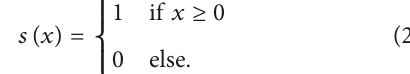
Figure 1: (a) Real face of the video image to capture the interval of 10 frames of the picture. (b) Face images taken from HD image attacks. (c) HD images of the human eye part with special treatment, adding eye movement. (d) Face images taken from video recordings.